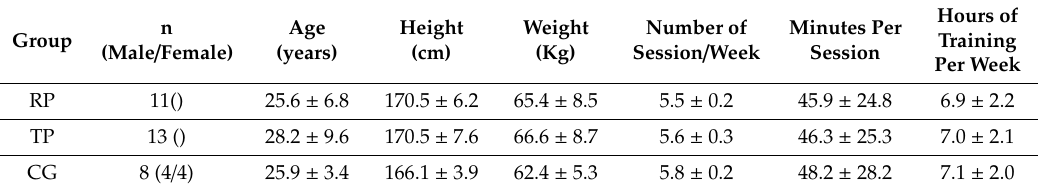
Table 1. Descriptive characteristics of the participants at baseline in the three groups, mean ± SD. n Group (Male /